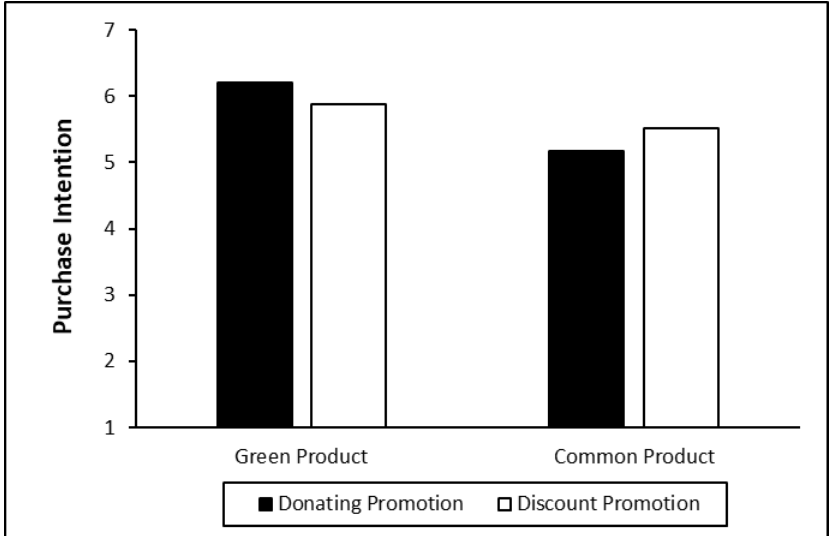
Figure 2. Consumers’ purchase intentions on green products vs. common products under different promotion modes.